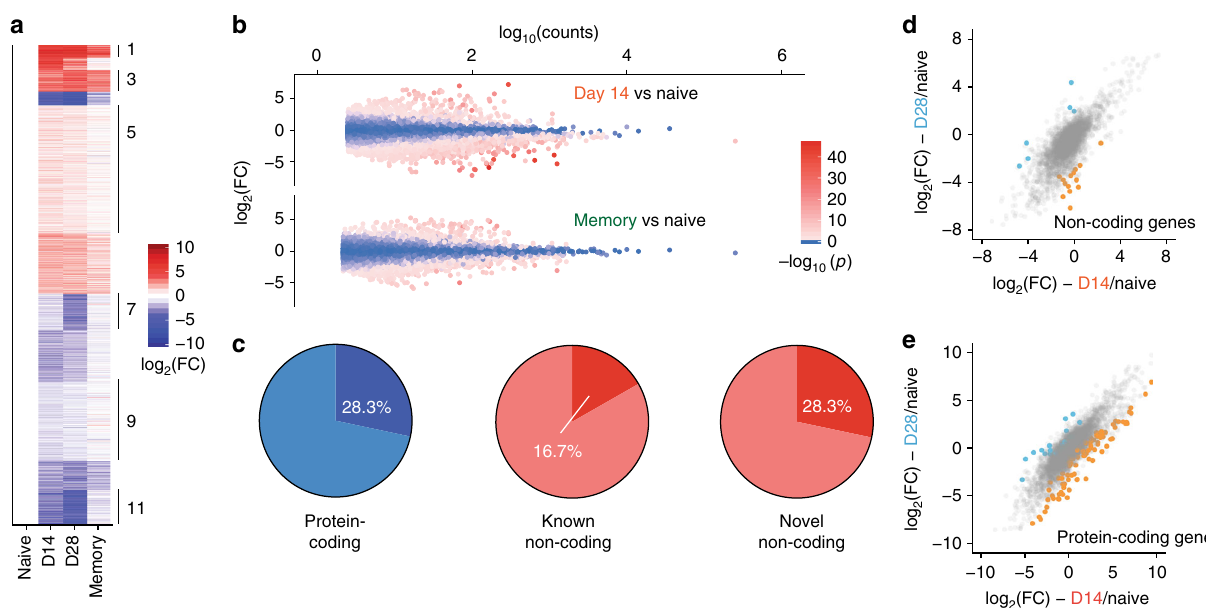
Fig. 5 Human CD8 + T cell differentiation is marked by large changes in lncRNA gene expression. a Heatmap showing expression of all differentially expressed genes in human CD8 + T cells during the response to yellow fever vaccination. b MA plot of noncoding genes in day 14 and memory yellow fever virus-speci fi c CD8 + T cells, compared to naive. c In humans, 28.3% of expressed protein-coding genes are differentially expressed throughout CD8 + T cell differentiation, compared to 16.7% of previously annotated lncRNA genes. In line with results from mice, a higher proportion of novel lncRNA genes (28.3%) are differentially expressed during CD8 + T cell differentiation compared to known lncRNA genes. d , e Changes in noncoding gene expression between day 14 and day 28 antigen-speci fi c CD8 + T cells. Colored points indicate signi fi cant expression differences between the two cell subsets. FC,